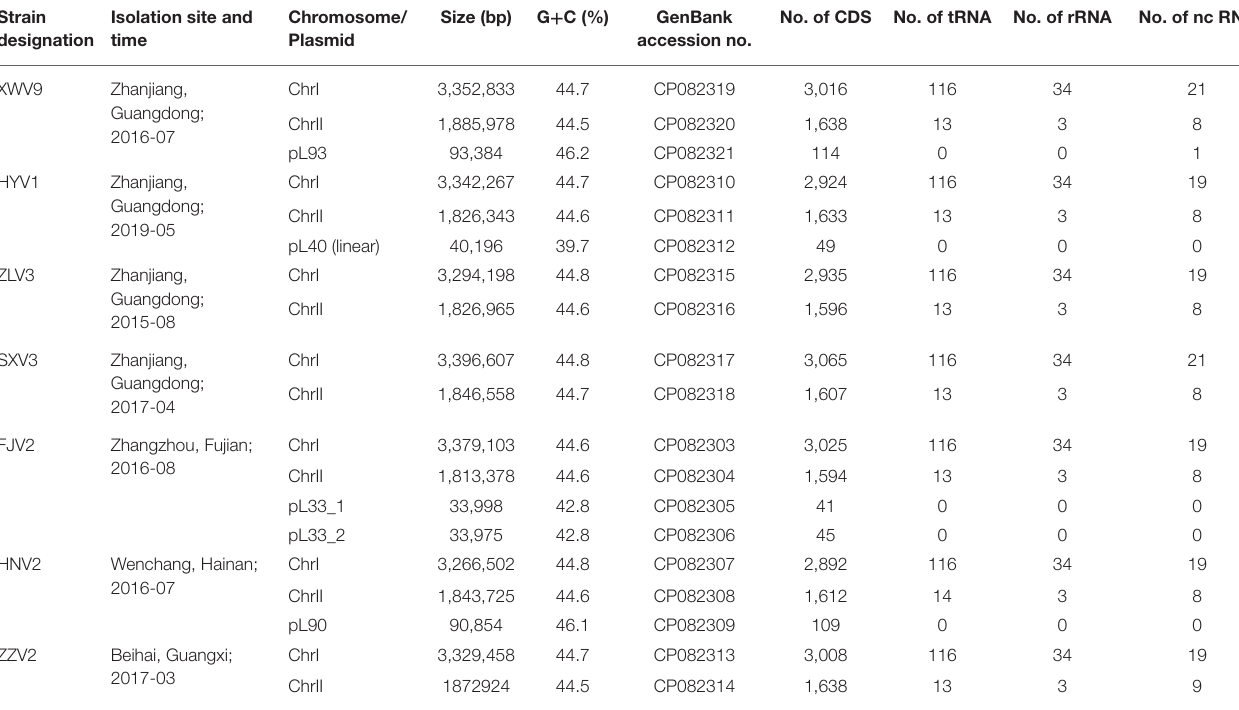
TABLE 1 | General features of the seven V. alginolyticus strains in this study. Strain Isolation site and Chromosome/ Size (bp) G + C (%) GenBank designation time Plasmid